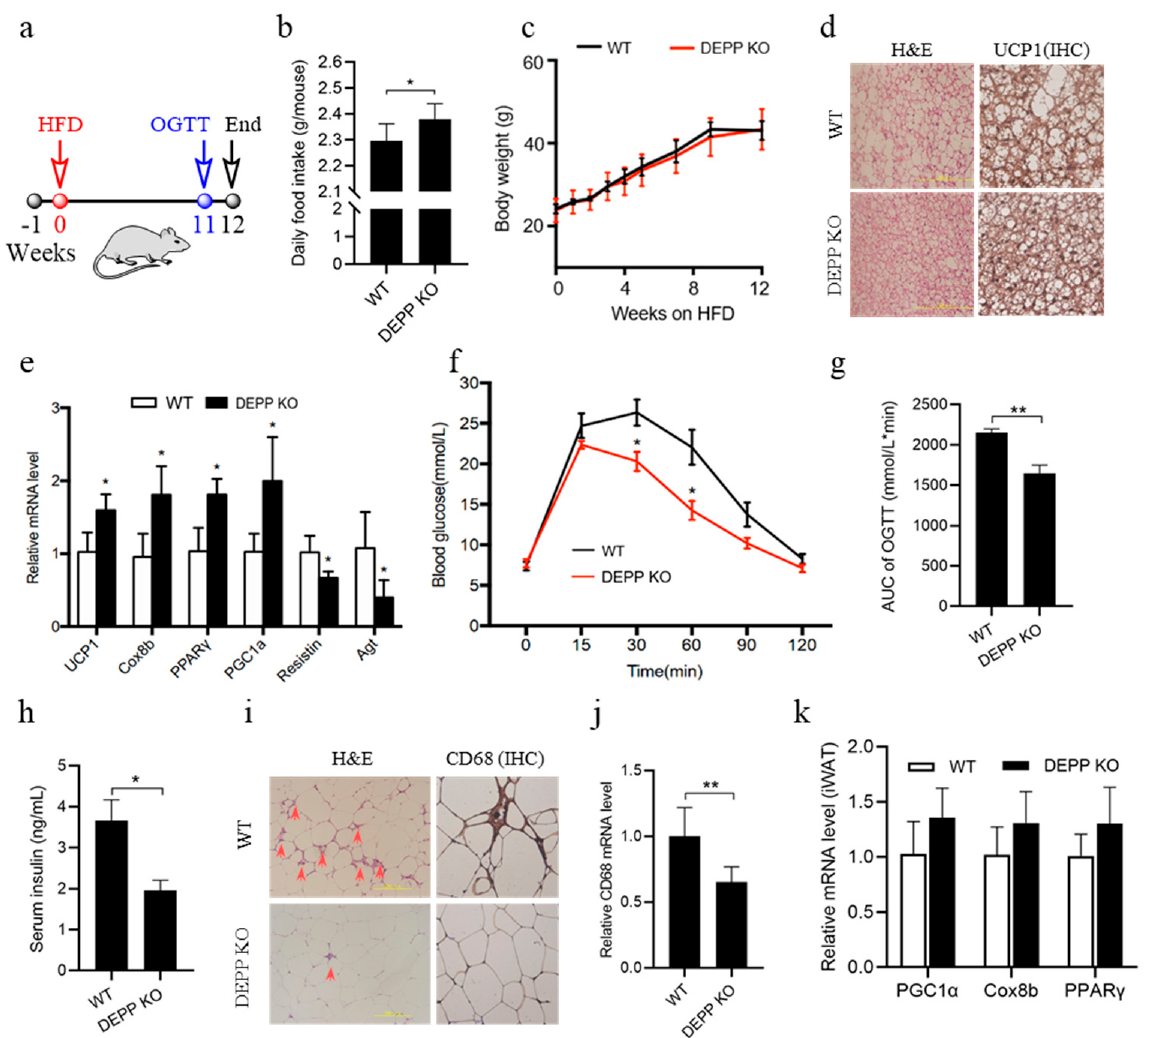
Figure 4. DEPP deficiency improved insulin sensitivity under HFD feeding in mice. ( a ) A high-fat diet (HFD) experimental flow chart for 12 weeks. ( b ) Food intake. ( c ) Body weight. For ( d , e , h – k ), samples were collected at the end timepoint of HFD feeding. ( d ) Representative images of H&E-